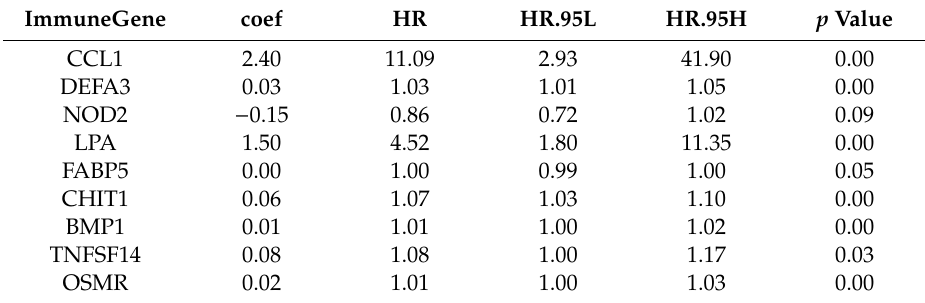
Table 2. Nine immune genes suitable for establishing a prognosis prediction model. Detailed information of each immune gene suitable for